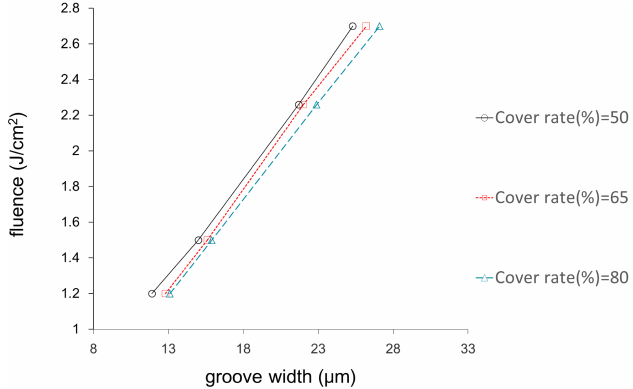
Figure 2. The relationship between the groove width and laser fluence at different cover rate.